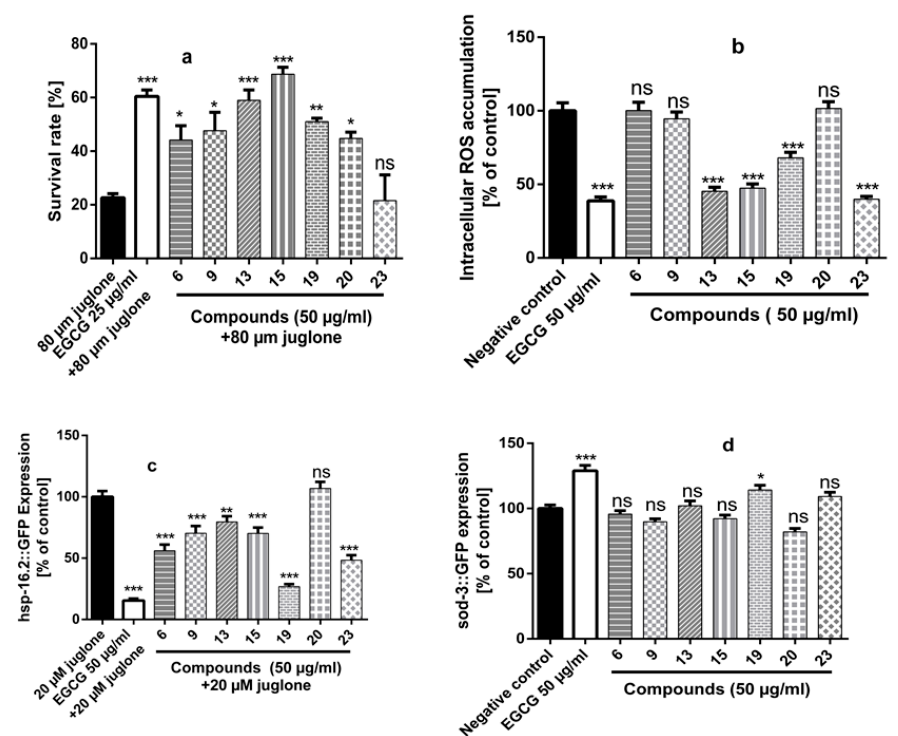
Figure 7. ( a ) E ff ect of compounds EGCG (epigallocatechin gallate) and compounds ( 6 , 9 , 13 , 15 , 19 , 20 , and 23 ) at concentration of (50 µ g / mL) on the survival rate of nematodes N2 under oxidative stress caused by toxic dose of Juglone (80 µ M). The pre-treatment of the worms with compounds ( 6 , 9 , 13 , 15 , 19 , and 20 ) (50 µ g / mL) significantly improved the survival rates. ( b ) Intracellular reactive oxygen species (ROS) accumulation in N2 worms, using H 2 DCF-DA. Results are expressed as the percentage of fluorescence pixel intensity related to untreated control (100%). ROS accumulation was significantly reduced after pre-treatment of N2 worms with compounds ( 13 , 15 , 19 , and 23 ) (50 µ g / mL). ( c ) hsp-16.2::GFP expression in the mutant TJ375 treated with EGCG, compounds ( 6 , 9 , 13 , 15 , 19 , 20 , and 23 ) after exposure to 20 µ M Juglone. All treated worms, except compound ( 20 ), showed downregulation of hsp-16.2::GFP compared to the untreated control. ( d ) sod-3::GFP Expression in the mutant strains CF1553 after pre-treatment with EGCG, compounds ( 6 , 9 , 13 , 15 , 19 , 20 , and 23 ) at concentration of (50 µ g / mL). Compound ( 19 ) showed significant up-regulation of sod-3 in mutants CF1553 related to the untreated control. The results are expressed as mean ± SEM from three independent experiments. Statistical significance of di ff erence between untreated control and treated groups was analyzed by one-way analysis of variance followed by Bonferroni (post hoc) [ns (not significant) p > 0.05, * p < 0.05, ** p < 0.01, *** p < 0.0001].